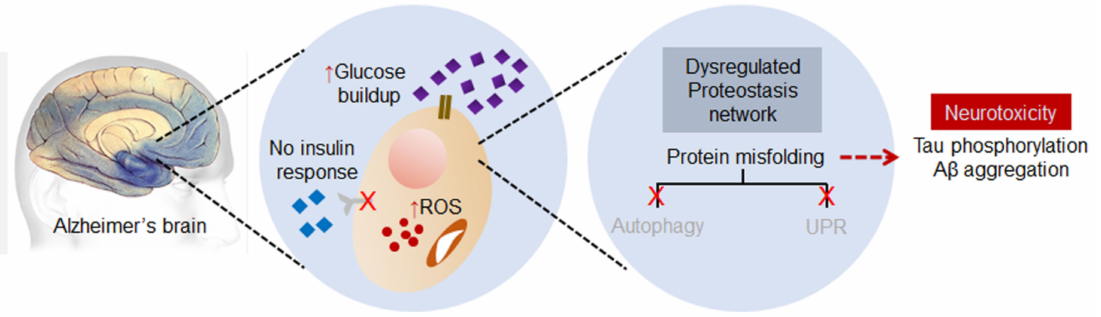
Figure 3. Dysregulated proteostasis network leads to neurotoxicity in AD brains. The UPR system usually ceases, and the buildup of aggregated A β plaques and additional misfolded proteins often induces cell death signals in the neurons. ↑ arrows indicate